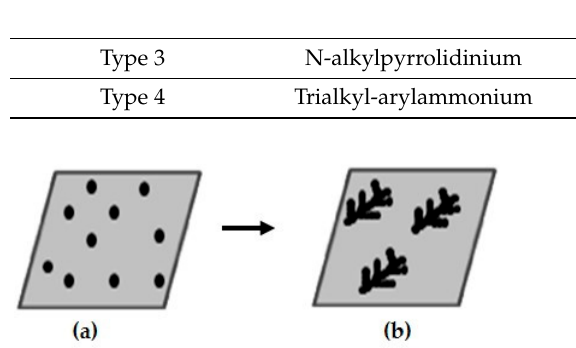
Figure 1. General schematic showing the change in the morphological features of Al deposited via galvanostatic deposition from chloroaluminate-based ILs at ( a ) ≤ 40 mA cm − 2 ; ( b ) ≥ 40 mA cm − 2. Table 3. Table listing the classification of chloroaluminate-based ionic liquids (ILs) employed for Al electrodeposition.